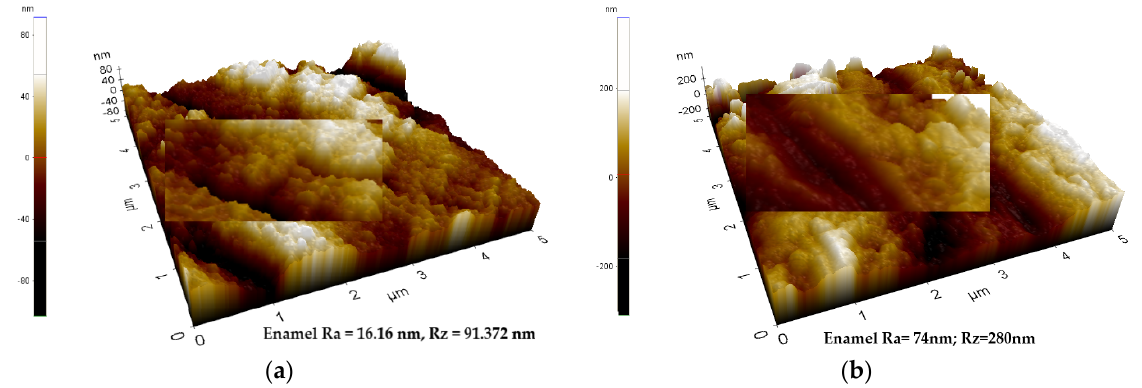
Figure 2. AFM image—Three-dimensional appearance of the enamel structure. The variability of the roughness profile can be observed at the level of enamel. ( a ) X Scan Size 5 μ m, Y Scan Size 5 μ m, Ra = 16.16 nm, Rz = 91.372 nm; ( b ) X Scan Size 5 μ m, Y Scan Size 5 μ m, Ra = 74 nm, Rz = 280 nm.